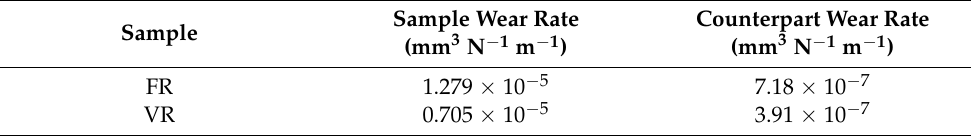
Figure 11. Sliding track of: FR ( a ) and VR ( b ) remelted samples. Table 5. Wear rate of the samples and